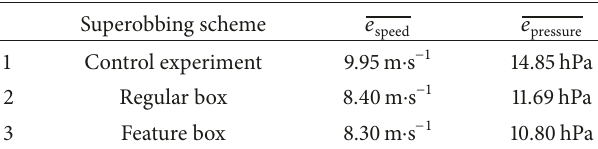
Table 4: Pressure and maximum wind speed forecast error of data assimilation